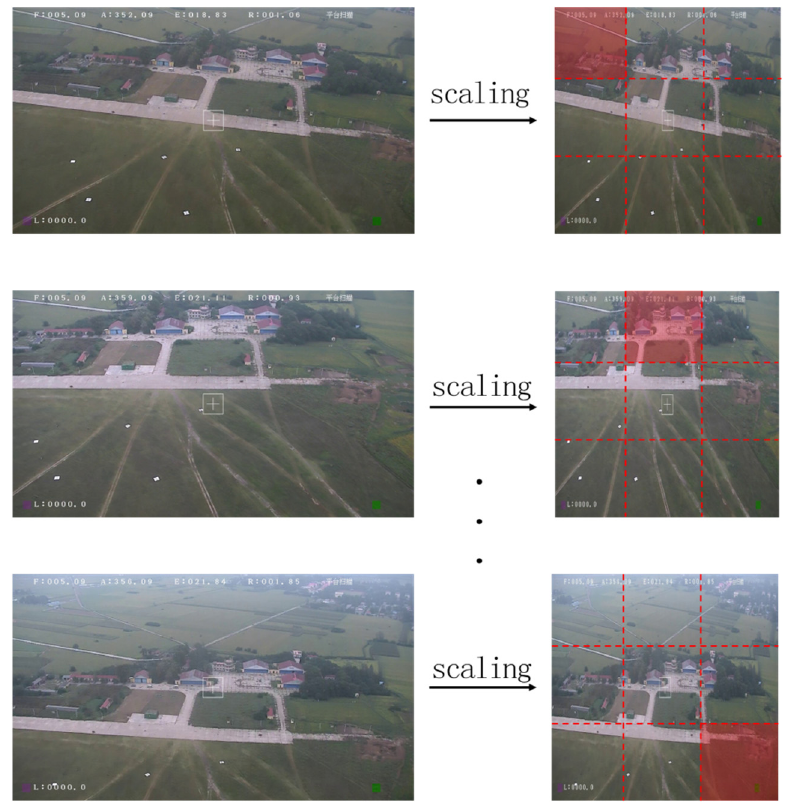
Figure 13. Schematic diagram of local drone image detection process.